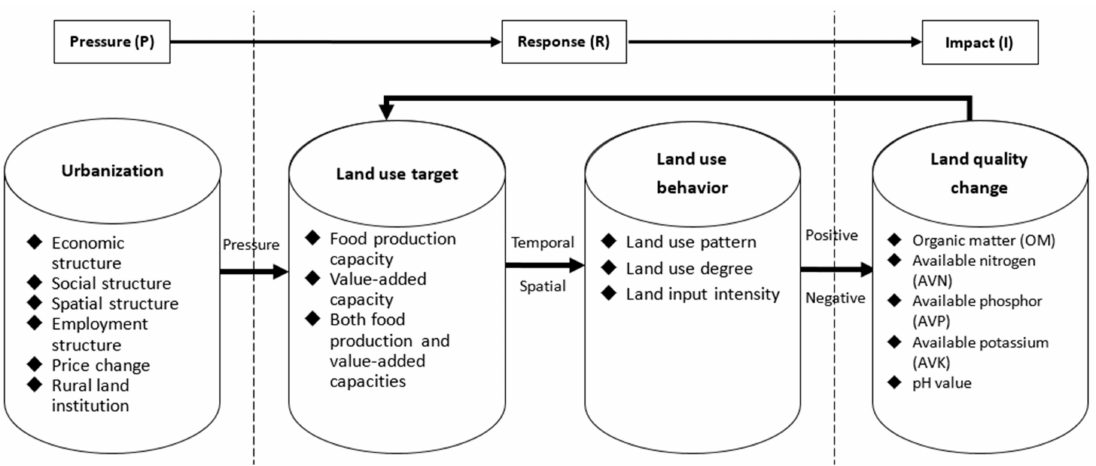
Figure 1. The theoretical framework of pressure-response-impact (PRI) based on households’ land-use